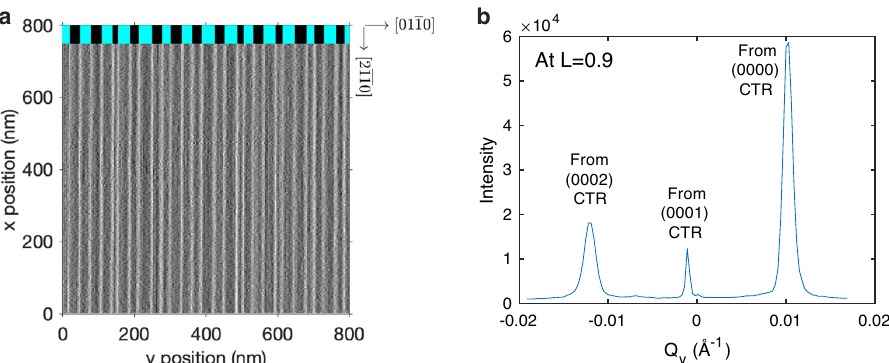
Fig. 4 Imaging and scattering from steps. a AFM image of steps of height c /2 (2.6 Å ) on the vicinal GaN substrate used in X-ray measurements. To emphasize the positions of steps, we plot the amplitude error signal, which is proportional to the height gradient in the scan direction ( y ). Image was obtained ex situ at room T after an anneal for 300 s at 1118 K in zero-growth conditions (0% H 2 , 0 TEGa). Average fraction over a 2 × 2 μ m 2 area of terrace family marked black at top is 0.47. The average double-step spacing of w = 573 Å corresponds to a miscut angle of tan (cid:3) 1 ð c = w Þ ¼ 0 : 52 (cid:4) . b Pro fi le of split CTRs from the vicinal surface, measured at T = 1170 K during growth at 0.053 μ mol min − 1 TEGa and 50% H 2 . The splitting of the CTRs Δ Q y = 0.0110 Å − 1 corresponds to a miscut angle of tan (cid:3) 1 ½ Δ Q y = ð 2 π = c Þ(cid:2) ¼ 0 : 52 (cid:4) , in agreement with the